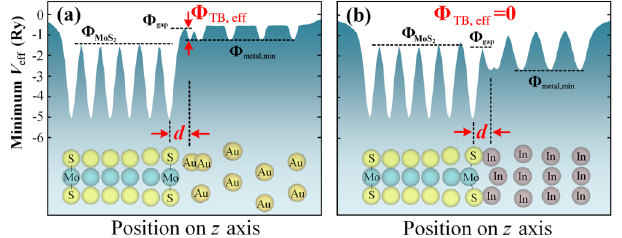
FIG. 19. Minimum V